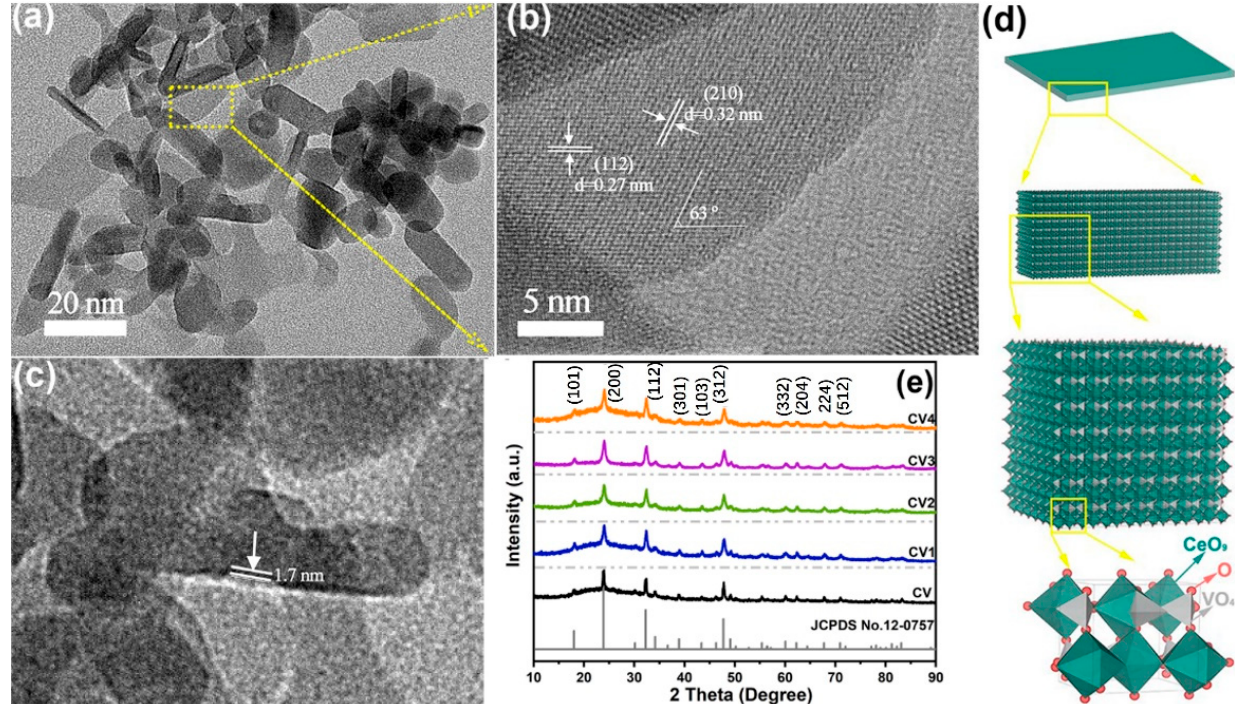
Figure 3. ( a ) TEM image, ( b ) HRTEM image, ( c ) TEM image with crimpled edges of the nanosheets (CV3) from the vertical direction, ( d ) crystal structure model of the CeVO 4 nanosheet, ( e ) XRD patterns of the as-prepared CV-CV4 samples and the standard spectrum of the tetragonal phase of CeVO 4 .